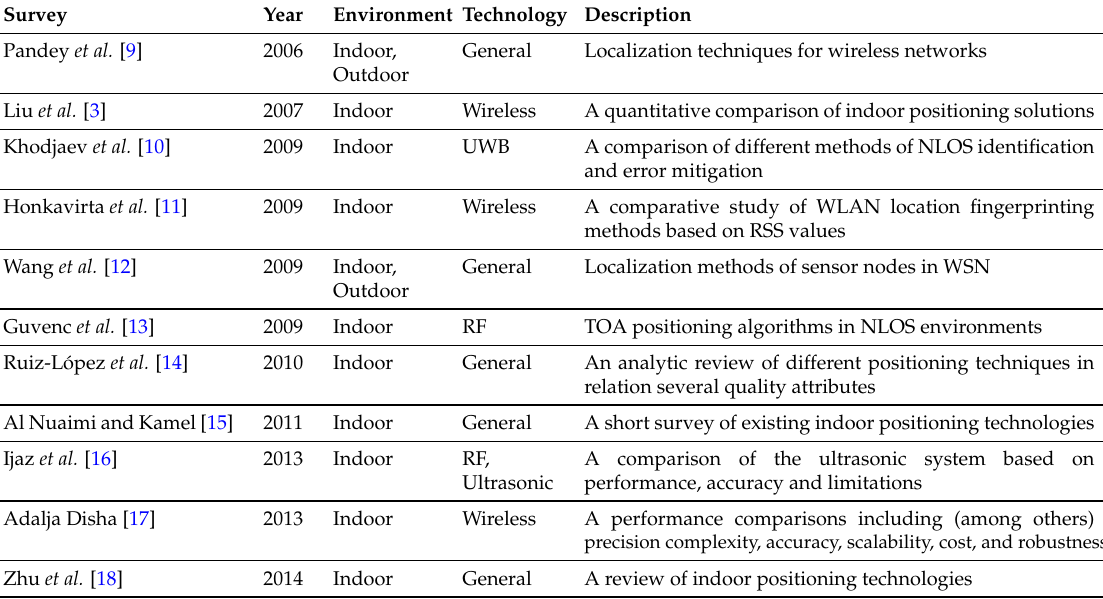
Table 2. List of related